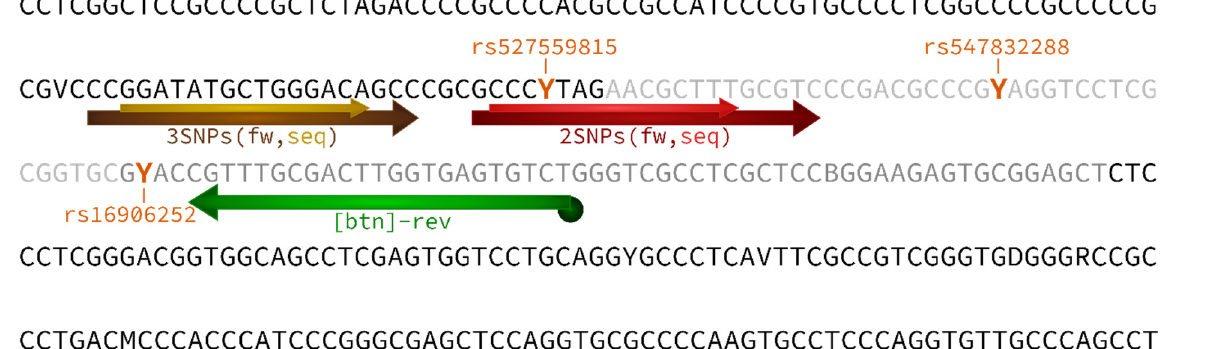
Figure 1. Schematic representation of part of the MGMT promoter region (Genbank GRCh38.p13 chr 10 NC_000010.11: range 129,467,138 to 129,467,477; 340 bp) containing the first exon, which is non-coding (marked in light gray), an enhancer element (gray, which includes the last 17 bp of exon 1), the primer binding sites (arrows), and all short variants of the 1000 Genomes project present in the Ensembl database. The 2 SNPs assay covers rs547832288 and rs16906252, and its forward (dark red) and sequencing (red) primer overlap with SNP rs527559815. The 3 SNPs assay, covering the SNPs (highlighted in orange) rs527559815 (position 129,467,237), rs547832288 (position 129,467,264), and rs16906252 (position 129,467,281), involves the forward (brown) and sequencing (ocher) primer. The biotinylated reverse primer (green) was used in both assays.